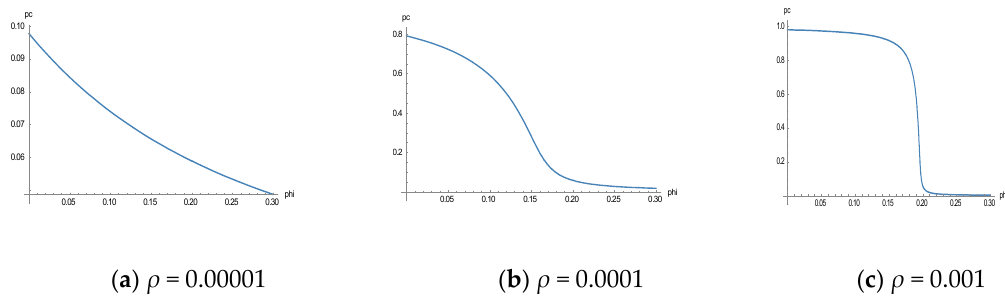
Figure 3. Tax compliance probability, p c , as a function of ρ .